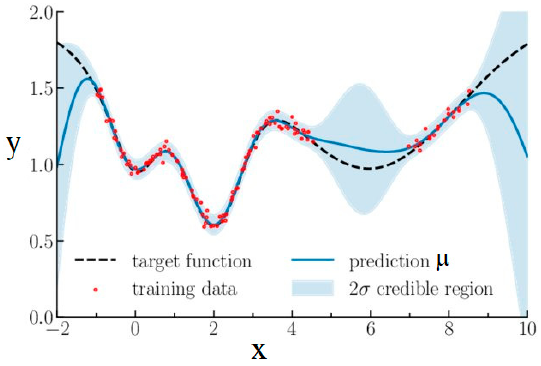
Figure 6. Example of Gaussian process in one dimension. Reprinted from [22] with permission from The American Chemical Society.